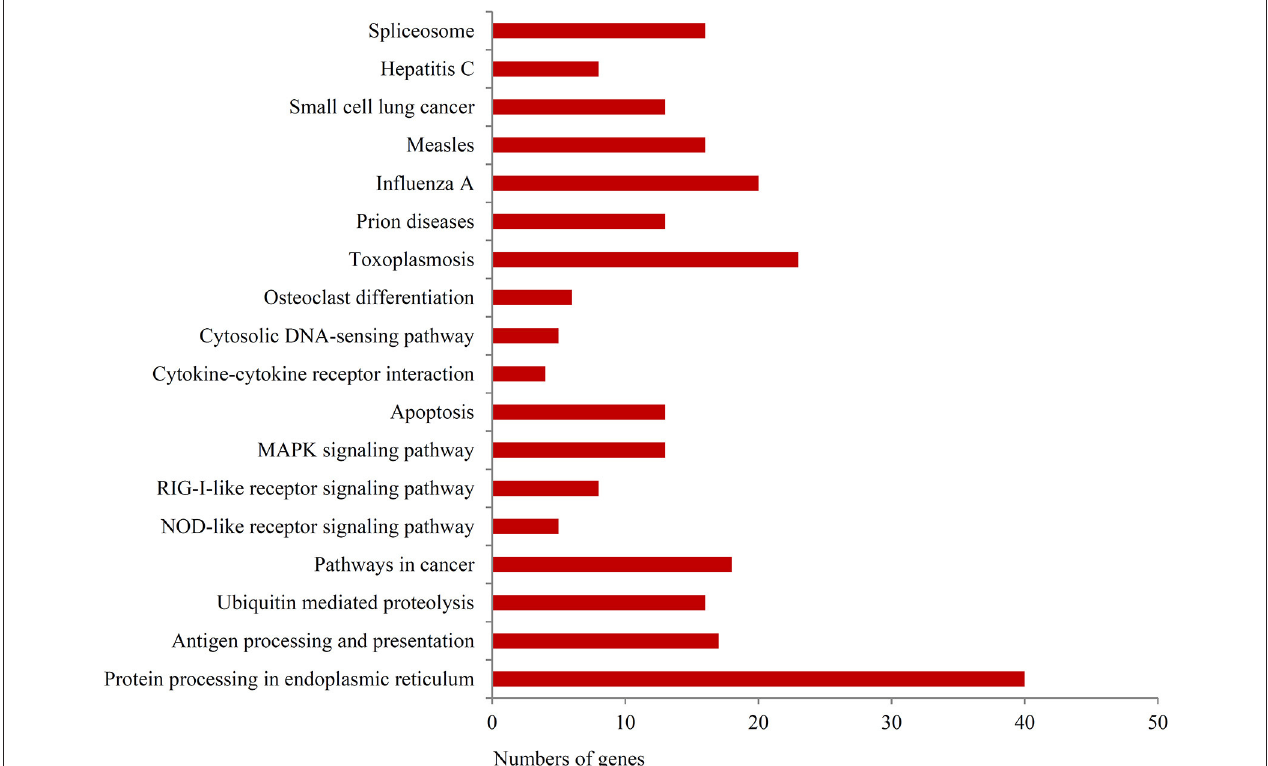
FIGURE 3 | KEGG pathway classification of identified